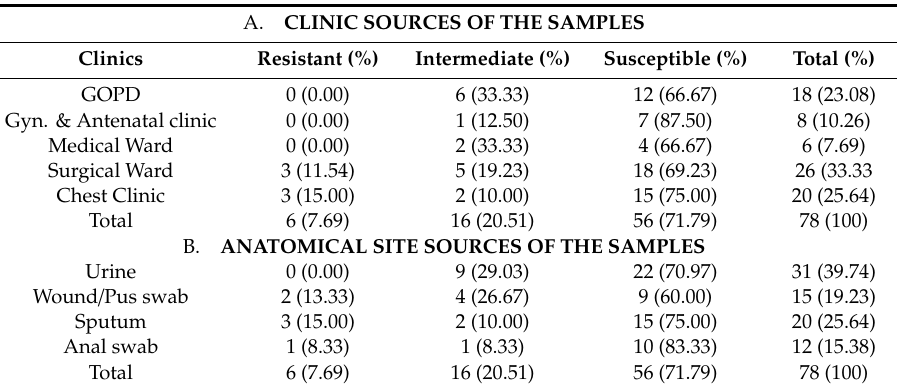
Table 3. Carbapenem susceptibility of isolates.